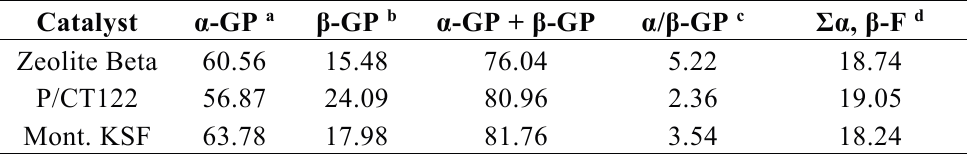
Table 3. Distribution of anomers in the glucosidation products obtained over three different type catalysts: zeolite Beta, the acidic cationite ion-exchange resin Purolite, and the KSF type montmorillonite.